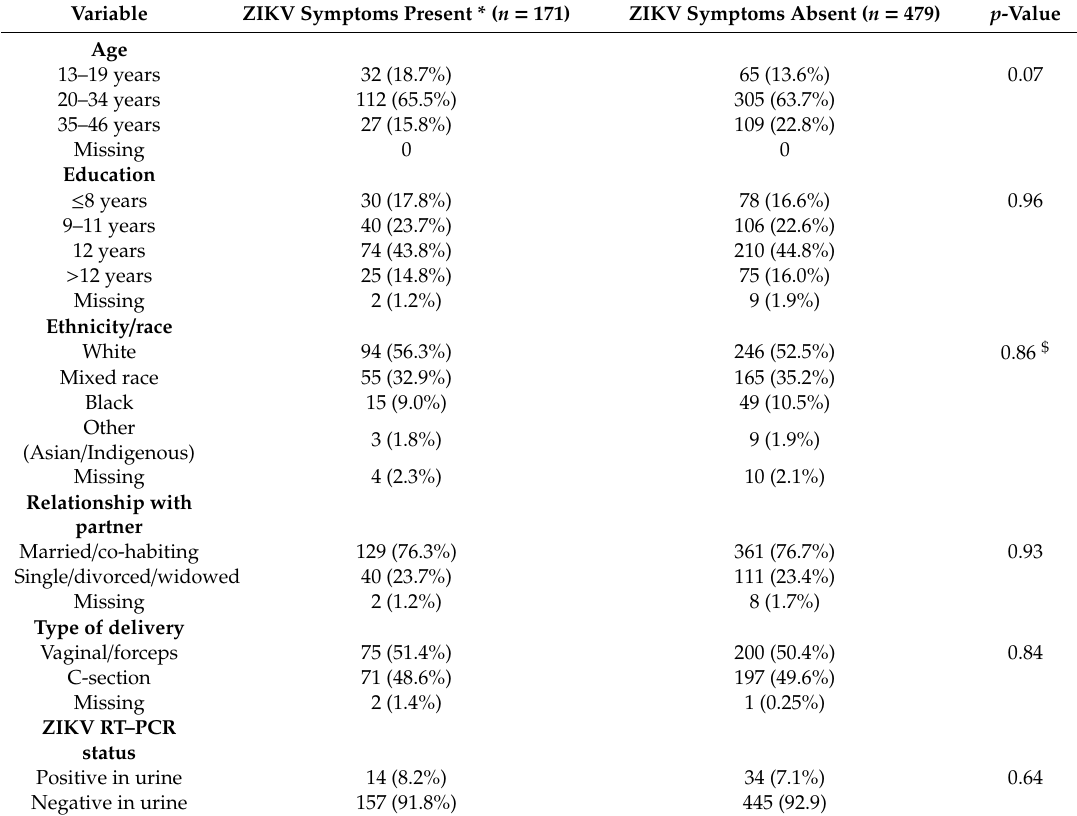
Table 2. Maternal characteristics of participants in the Jundia í Zika Cohort.